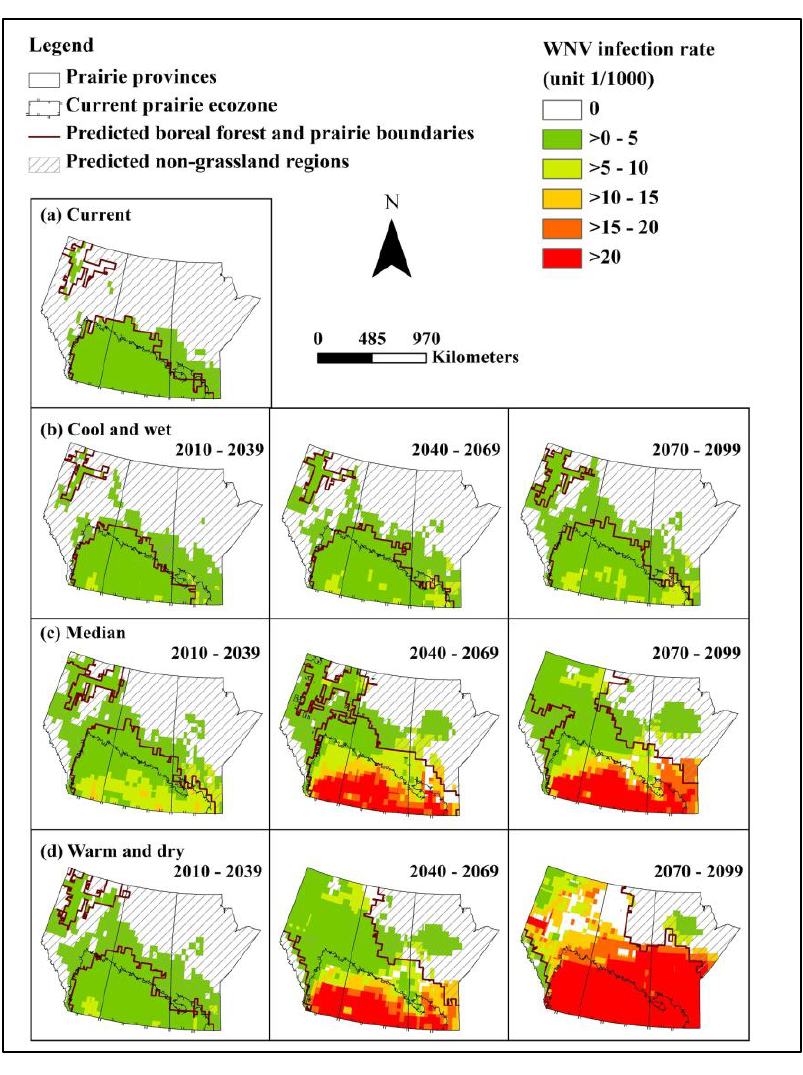
Figure 3. Projected WNV infection rate in Cx. tarsalis in August in the prairie provinces under the current (1961–1990) and selected outcome scenarios in three future time periods. The possible spatial distribution of WNV restricted by the predicted grassland distribution is indicated by the solid red